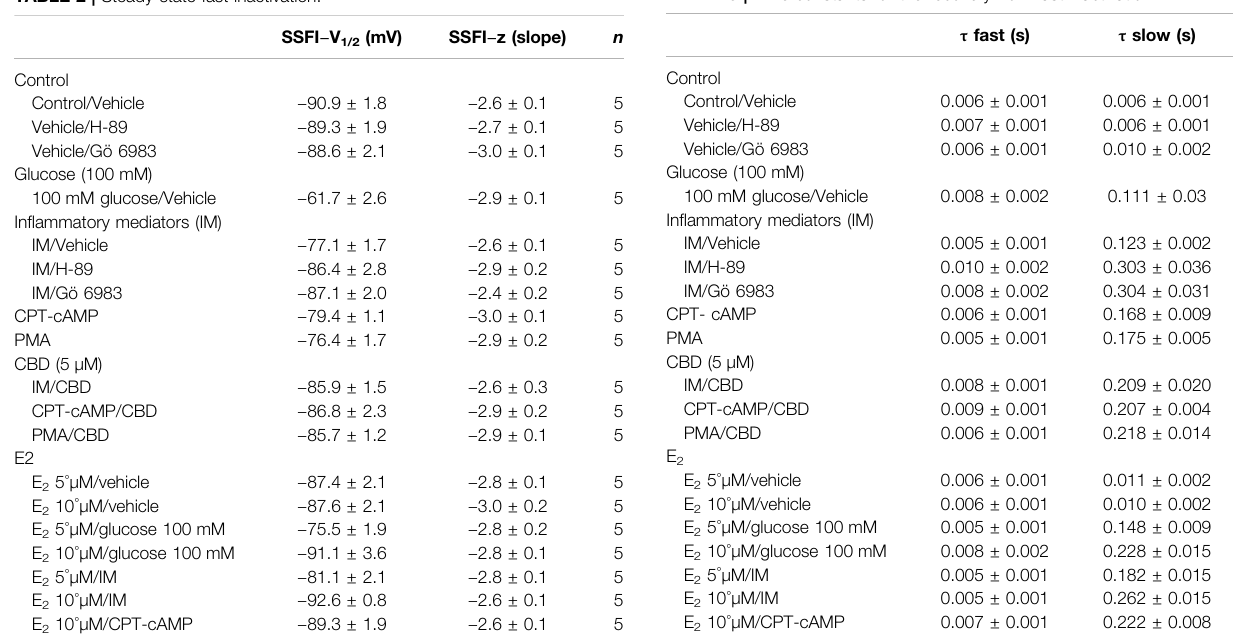
TABLE 2 | Steady-state fast inactivation. TABLE 3 | Time constants for the recovery from fast